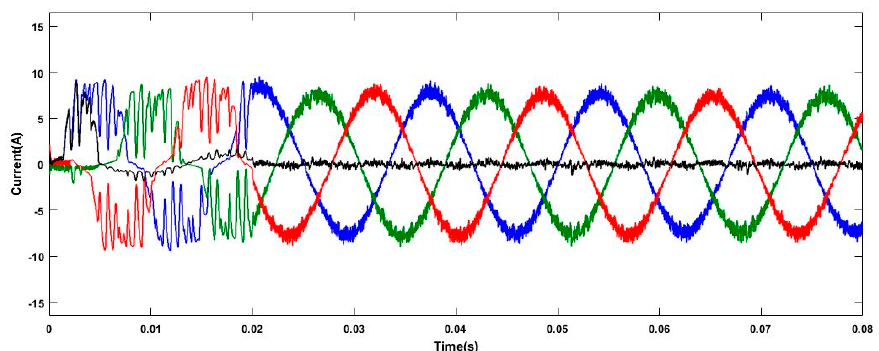
Figure 7. Compensation result with the traditional p-q method for case 1.